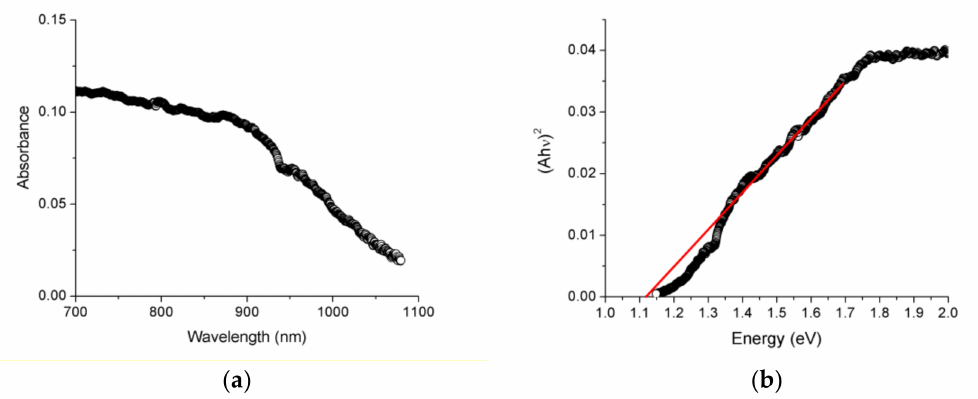
Figure 6. Absorbance spectra ( a ) and solid-state UV-Vis direct bandgap Tauc plot ( b ) for EuP 2